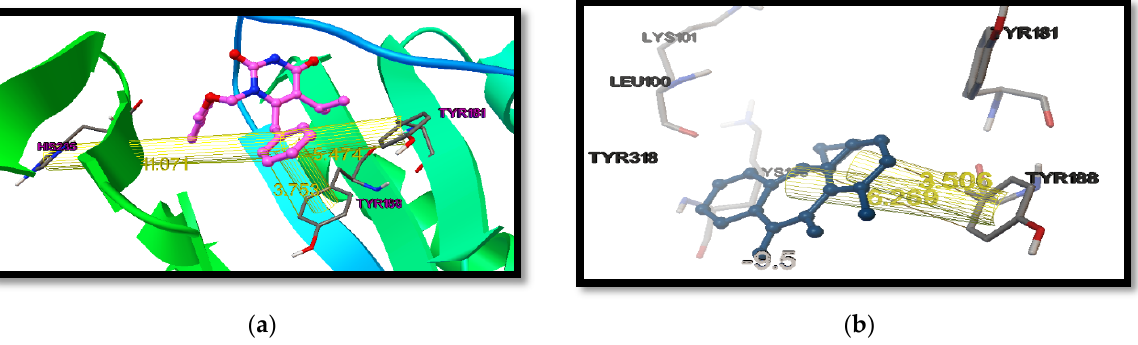
Figure 4. ( a ) Redocking of co-crystallized ligand TNK ( 29 ) in the binding pocket of HIV-1 reverse transcriptase (1RT2). Ligand is shown as pink line model and the amino acid residues interacting with the ligands are shown as conventional colored line model. Π-bond interactions (3.753, 5.474, 11.071 Å) with amino acid residues of HIV-1 reverse transcriptase are shown as lines. ( b ) Binding mode of standard drug nevirapine ( 30 ) in the binding pocket of HIV-1 reverse transcriptase (1RT2). Ligand is shown as blue-colored ball and stick model and the amino acid residues interacting with the ligands are shown in conventional colored line model. Π-bond interactions (6.269, 3.506 Å) with amino acid residues of HIV-1 reverse transcriptase are shown as lines.